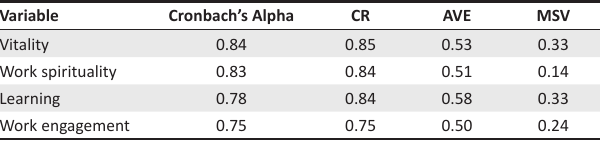
TABLE 1: Reliability and validity assessment. Variable